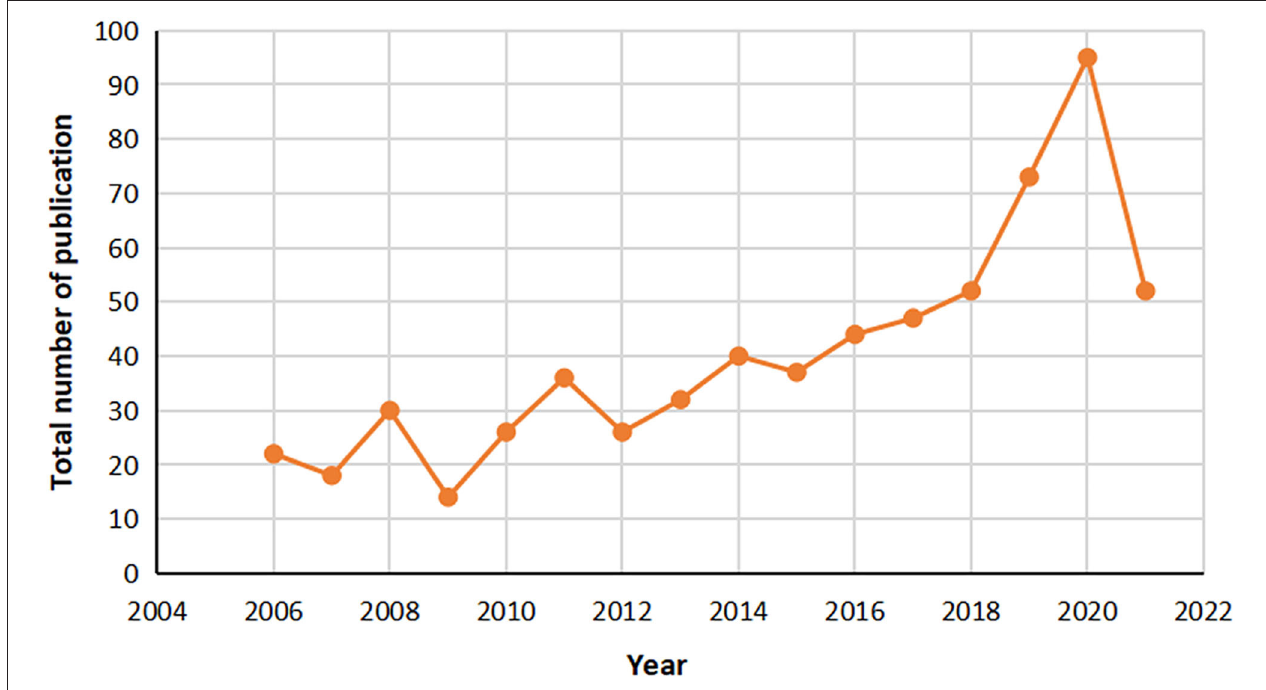
FIGURE 2 | Annual publication curve of WOS (2006–2021) in the field of intrauterine adhesion. The abscissa in the figure represents the year and the ordinate represents the total number of publications.